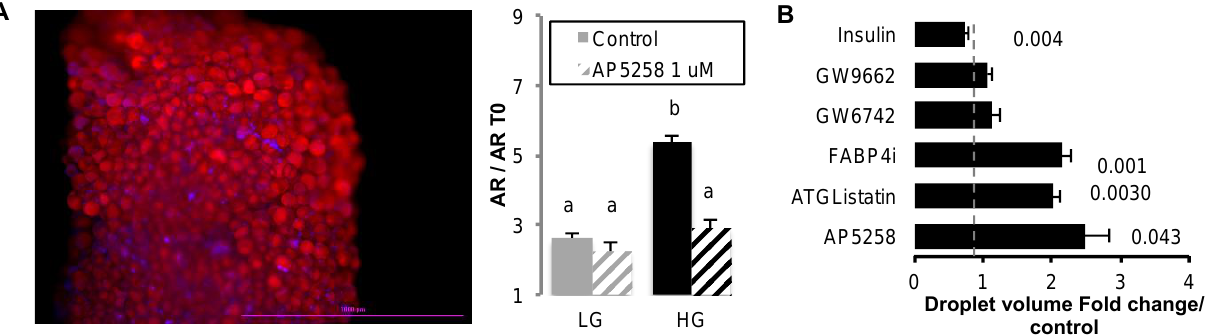
Figure 1. Differential effects of FAT/CD36 inhibition in 3T3-L1 cell cultures versus adipose tissue explants. ( A ) Rat adipose tissue explants were treated during 48 h in low LG (1 g/L) versus high glucose (HG 4.5 g/L) media either alone or in presence of FAT/CD36 inhibitor AP5258 (1 μ M). An example of rat adipose tissue explant labeled with AdipoRed (red) and Hoechst 33258 (blue) is presented, the scale bar represents 1 mm. Triglyceride contents were quantified using AdipoRed (AR) uptake after 40 min, fluorescence intensity was normalized at the time the marker was added (T0). Inhibition of FAT/CD36 induced a reduction of lipid content increase observed in HG media by comparison to LG media. Data are presented as mean fold changes AR after 40 min to T0 +/ − SEM (n = 8), different letters represent significant differences (ANOVA test, p < 0.05). ( B ) Analysis of droplet size regulation 3 days after treatment with oleic acid (10 μ M) in HG culture media in 3T3-L1 adipocytes. In presence of either lipolysis inhibitor ATGListatin (1 μ M), AP5258 (1 μ M), or cell-permeable FABP4 inhibitor (FABP4i 20 μ M), lipid droplet sizes were increased. PPARA or PPARG (inhibited respectively by GW6471 and GW9662, 10 μ M each) did not affect both cell lines. Insulin (0.05 U/mL) was used as a control of the inhibitory effect on droplet size increase. Results were obtained in independent experiments and normalized to corresponding control media (n = 8 biological replicates), and significant Student t -test p -values ( p < 0.05) are indicated.